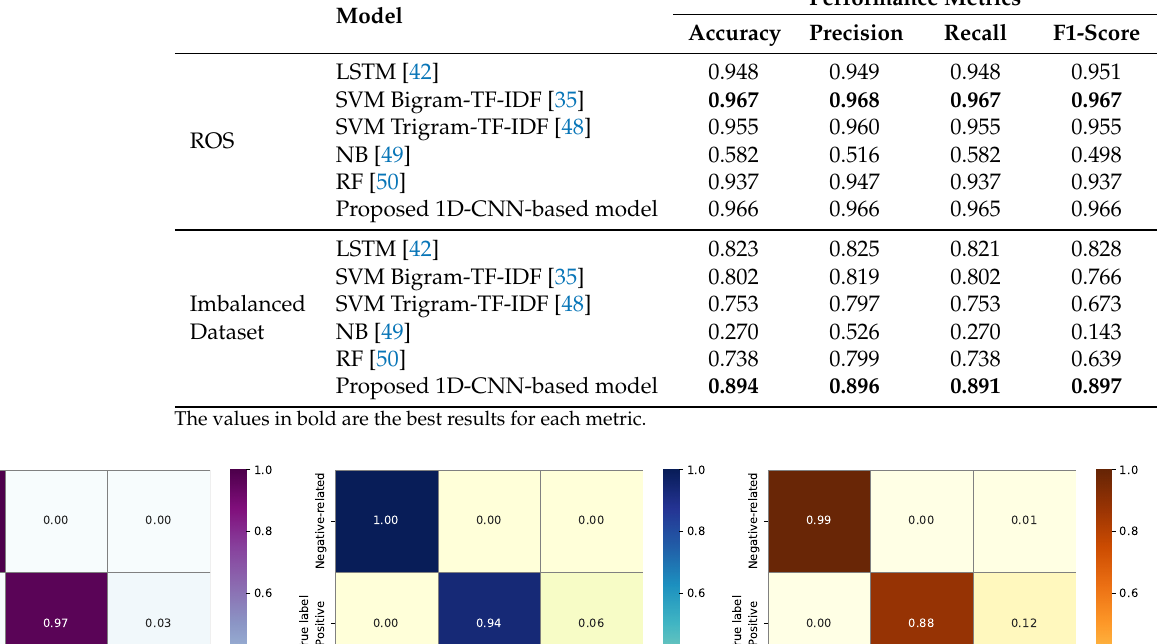
Table 8. Performance comparison of the proposed model with state-of-the-art methods. Model